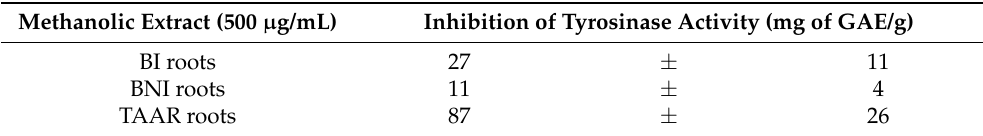
Table 3. Tyrosinase inhibitory activity of methanolic extracts of date palm roots. Methanolic Extract (500 µ